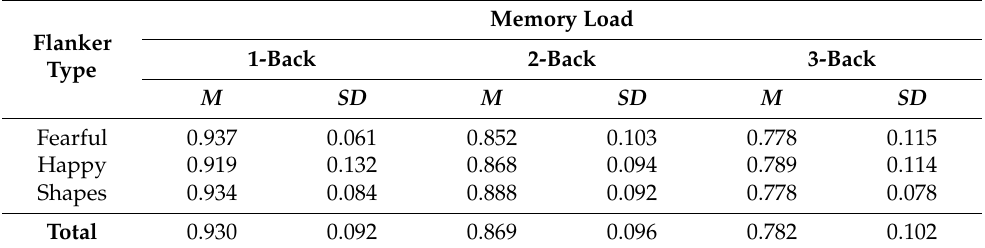
Table 9. Means and SDs of participants’ accuracy rates for all conditions for Study 2.